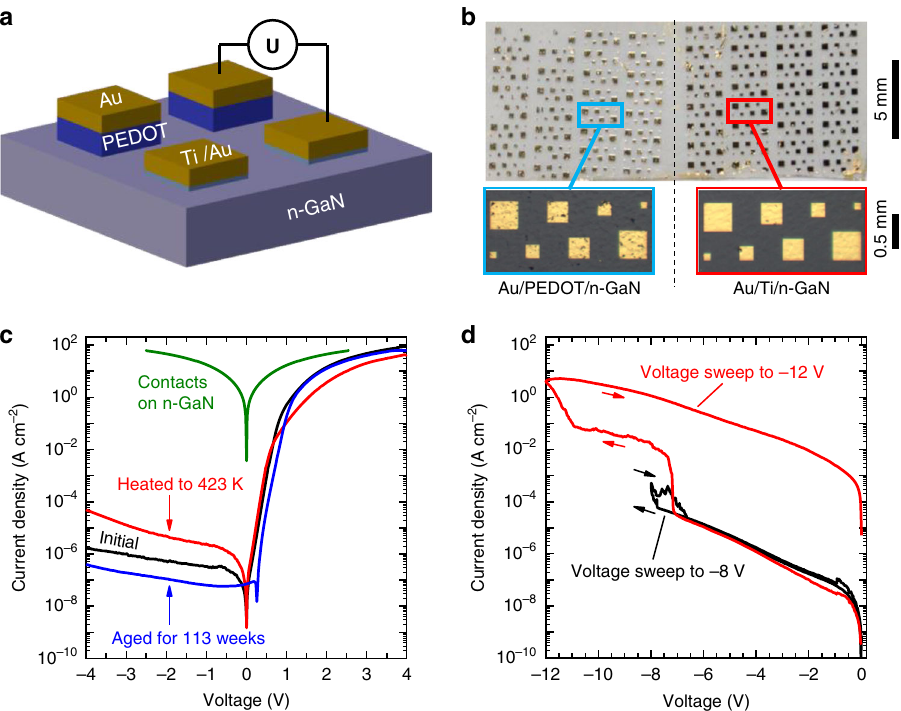
Fig. 2 Design and electrical characterization of planar heterojunction structure. a Sketch of the sample. b Photography (scale bar: 5 mm) of as-prepared devices with magni fi ed view (scale bar: 0.5 mm) of the p- and n-type contact pads, respectively. c I – V characteristics of the hybrid n-GaN/PEDOT heterojunctions. Minor differences from the original performance (black) occur after either heating to 423 K and cooling back to 293 K (red) or 113 weeks of aging at ambient conditions in the dark (blue). The overall forward current density is limited by the series resistance of n-GaN as determined by I – V measurements of Au/Ti/n-GaN/Ti/Au structures (green). d Determination of the breakdown voltage, soft (black) and hard (red) breakdown occur at − 7.8 and − 10.8 V,